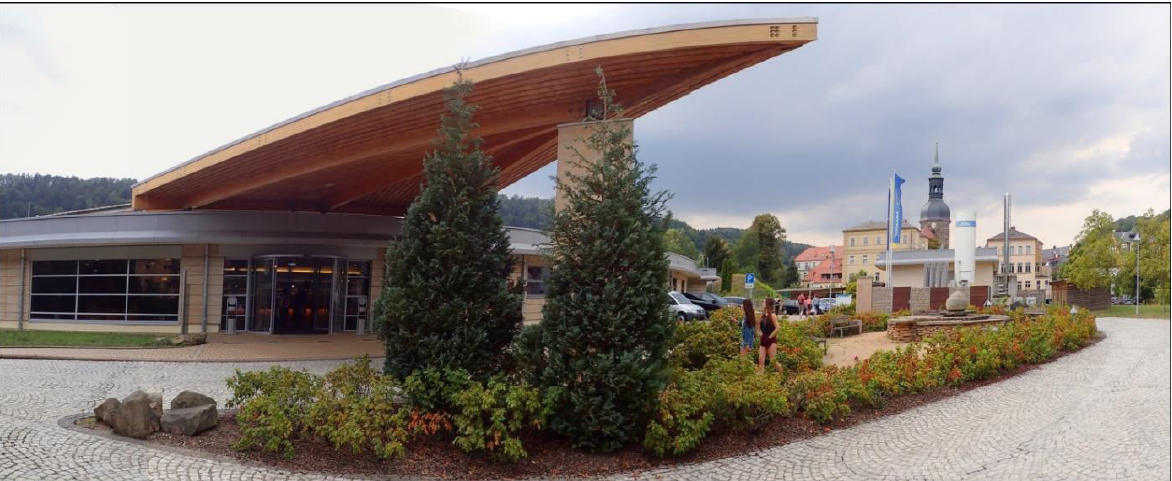
Figure 8. Entrance to the modern thermal baths building in Bad Schandau against a panorama of the historical part of the